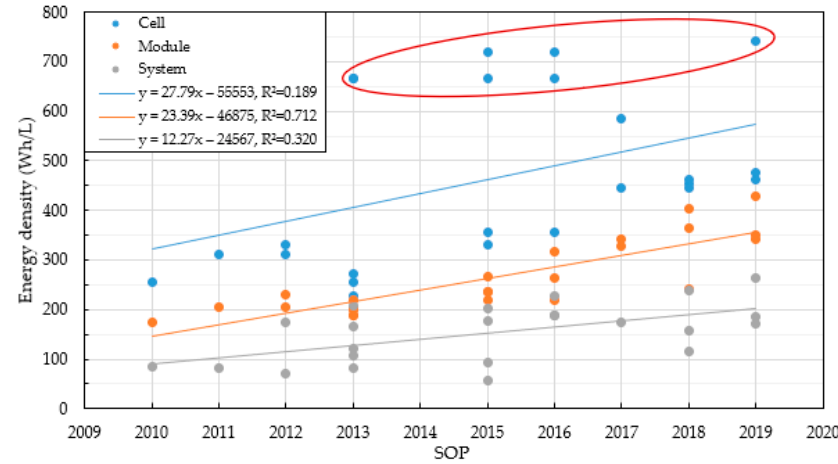
Figure 3. Development of the energy density (Wh/L) in the years between 2010 and 2019. Blue represents the development on cell level, orange represents the module level, and grey represents the system level.